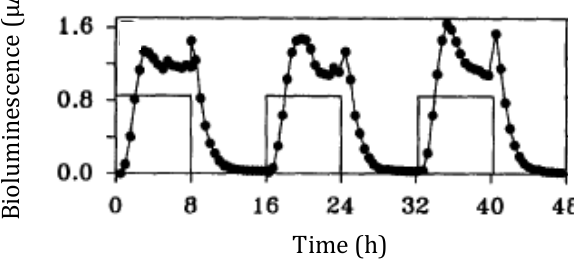
Figure 4. By treating with naphthalene over 8 h intervals (black boxes), King et al . were able to demonstrate a corresponding dose/response bioluminescent production ( (cid:121) ) curve. Adapted and used with permission from